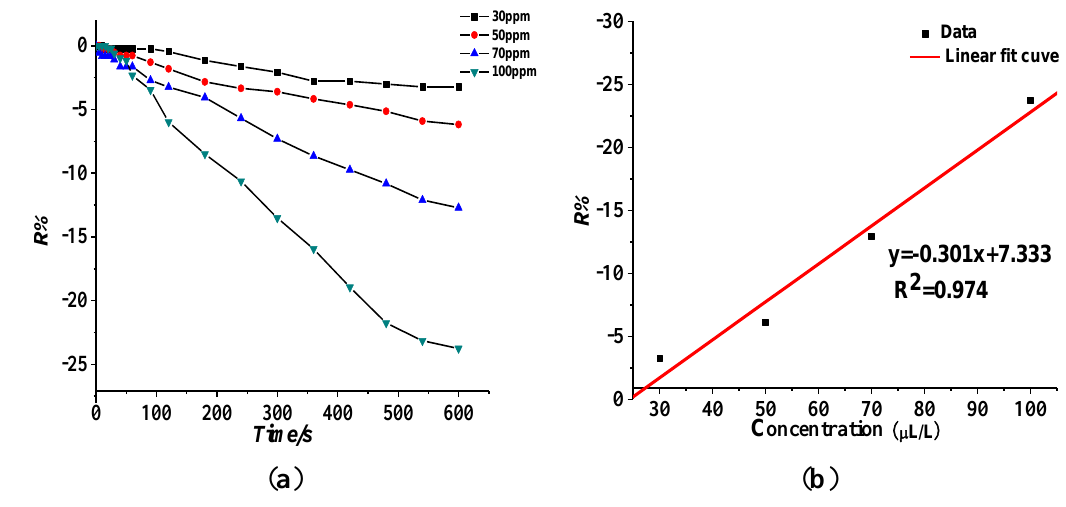
Figure 8. Response of the Pt-doped TiO at 150 °C operating temperature. ( a ) Response of the sensor’s gas-sensing characteristics to different concentrations of SOF gas concentration.